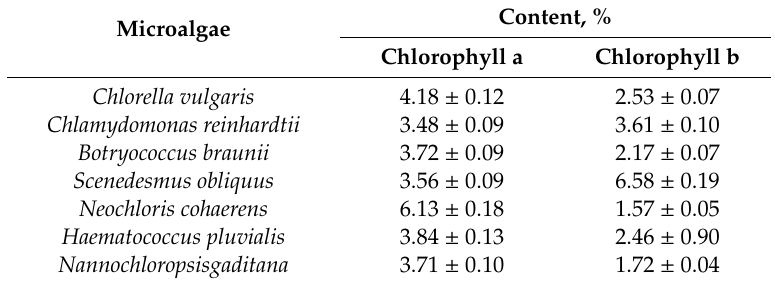
Table 9. Chlorophyll a and b content in microalgae (table built using combined data from previous studies